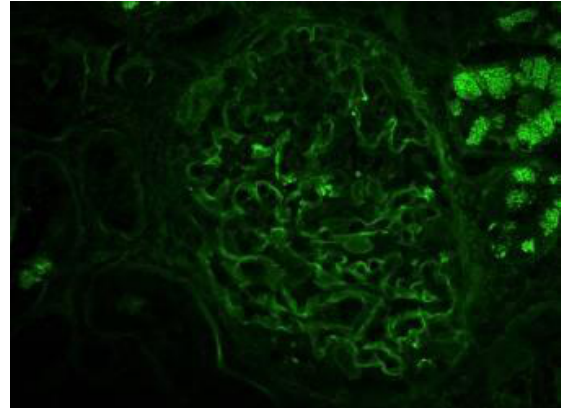
FIGURE 3 . IF: IgG. FIGURE 4. IF: C3.